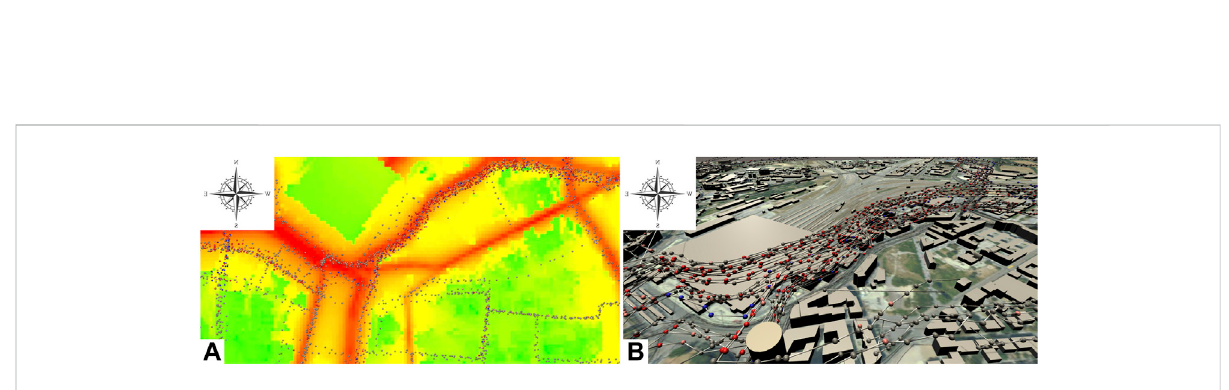
FIGURE 10 Comparison of simulated and measured noise pollution (A) and display of the daytime in the z-axis to identify temporal and spatial patterns of noise (B)